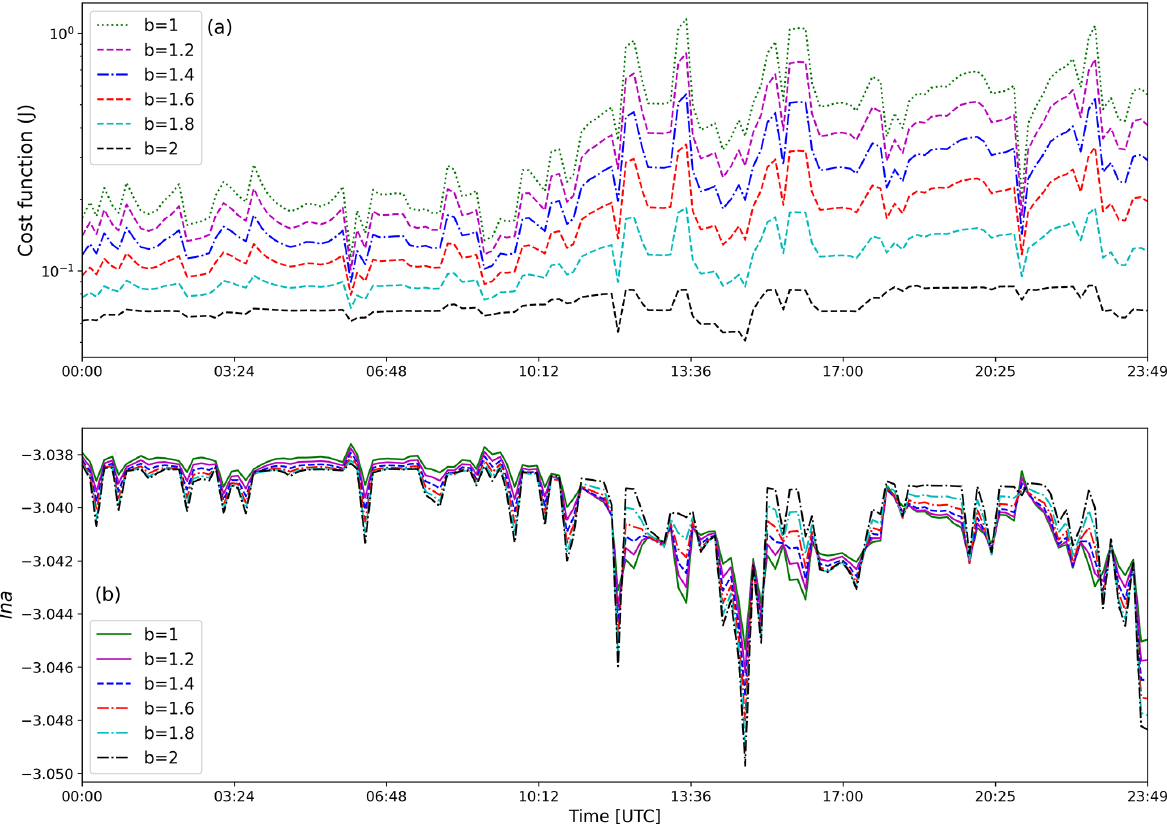
Figure A2. (a) Cost function and (b) retrieved ln a for different b